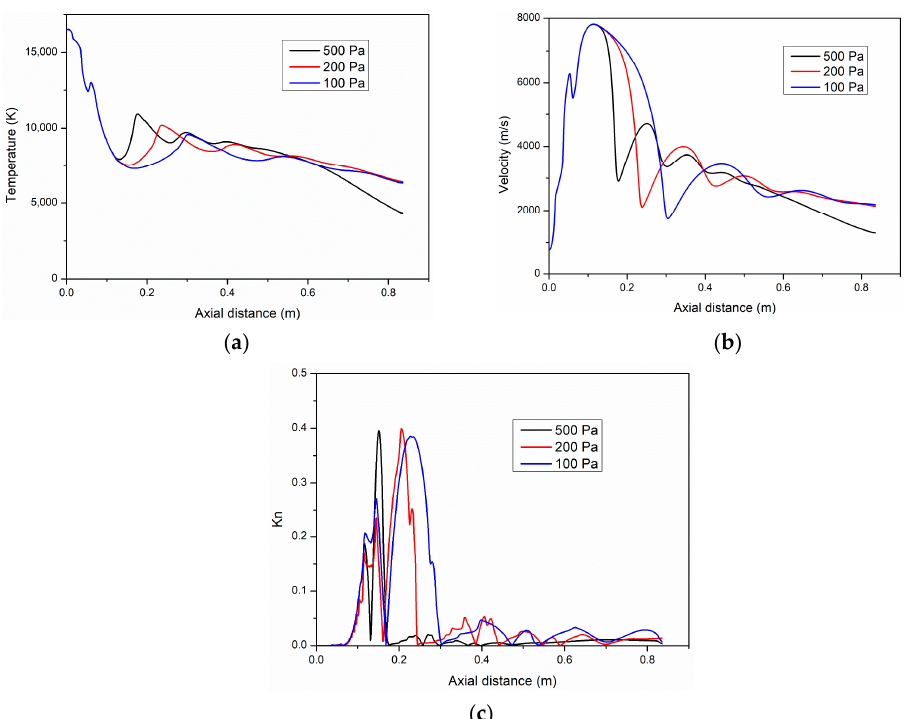
Figure 8. Variation of the 40Ar–8H 2 plasma jet ( a ) temperature, ( b ) velocity, and ( c ) Knudsen number along the torch axis distribution for different chamber pressures at a power input of 40 kW.